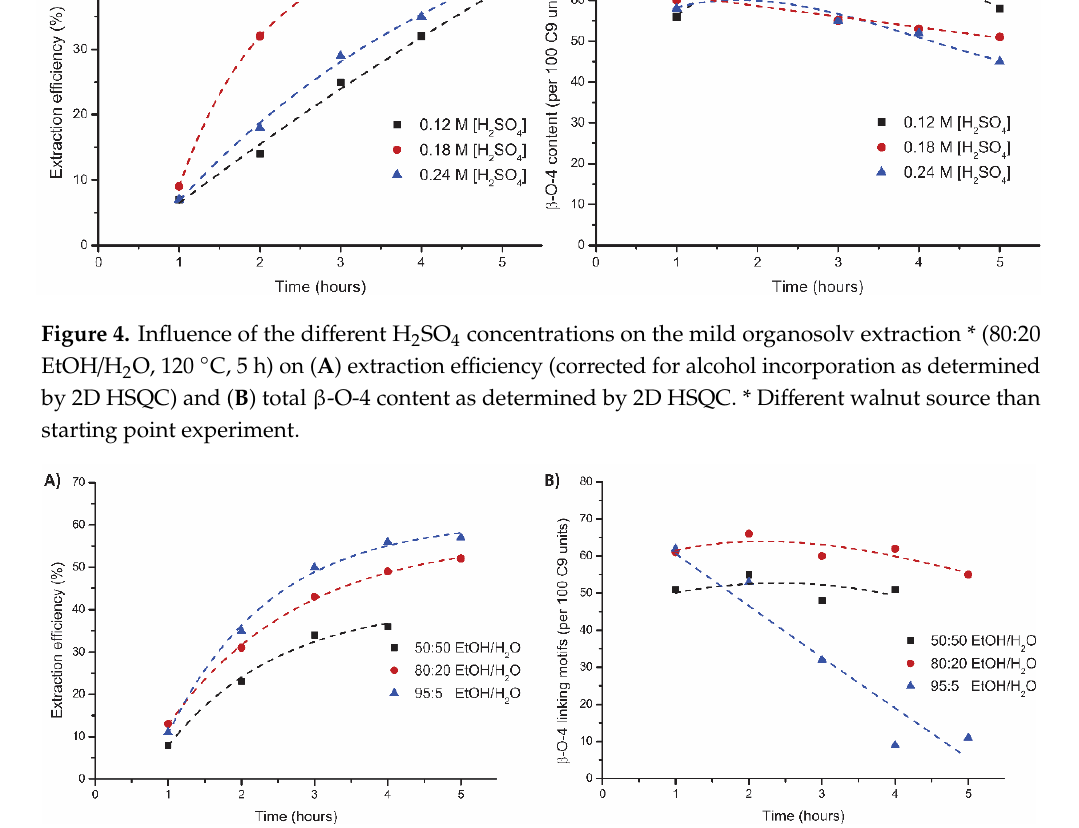
Figure 5. Influence of the different EtOH/H 2 O on the mild organosolv extraction * (0.18 M H 2 SO 4 , 120 C, 5 h) on ( A ) extraction e ffi ciency (corrected for alcohol incorporation as determined by 2D HSQC) °C, 5 h) on ( A ) extraction efficiency (corrected for alcohol incorporation as determined by 2D HSQC) and ( B ) total β -O-4 content as determined by 2D HSQC. * The 50:50 EtOH / H 2 O experiment was stopped and ( B ) total β-O-4 content as determined by 2D HSQC. * The 50:50 EtOH/H 2 O experiment was after 4 h due to the reactor stopped after 4 h due to the reactor clogging.